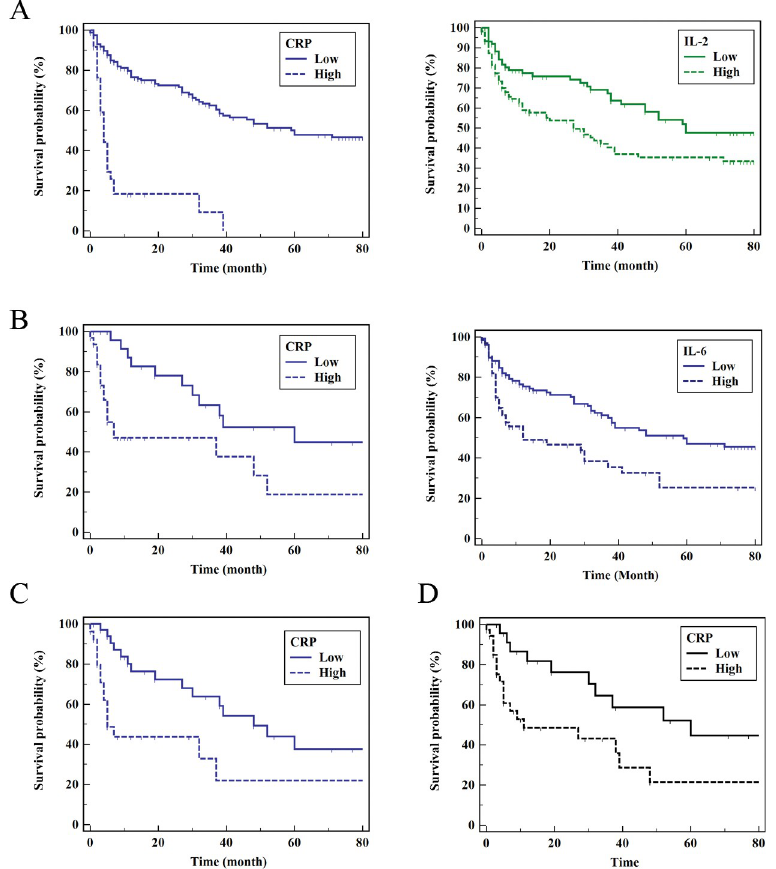
Fig 3. Patient outcome by cytokine status. Overall survival of patient group by high and low concentration of cytokines after transarterial chemotherapy is presented. (A) CRP and IL-2 at D0, (B) CRP and IL-6 at D3,(C) CRP at D7 and (D) CRP at